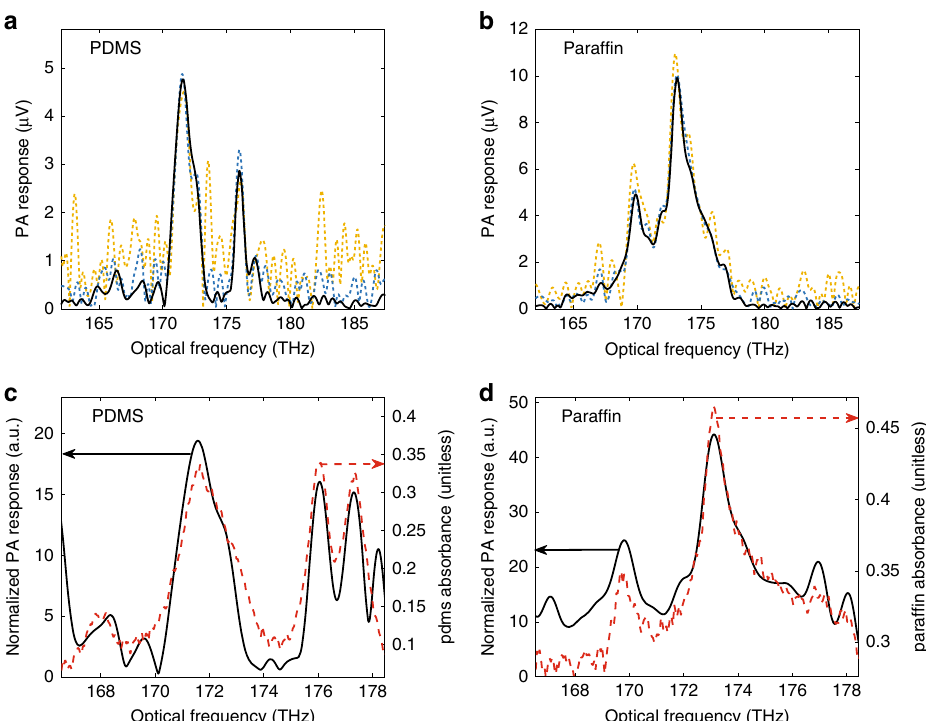
Fig. 4 Spectrally resolved dual-comb photoacoustic responses of polymer fi lms. a , b show the PA response for PDMS ( a ) and paraf fi n ( b ) obtained by Fourier transformation of the time-domain signal at the transducer output (obtained by dividing the measured signal by the ampli fi er gain) followed by scaling to optical frequencies (Eq. (2)). The averaging times are 4 min, 20 min, and 120 min for the yellow-dotted, blue-dotted, and black-solid traces, respectively. c , d show the normalized PA response from Eq. (4) (solid black) compared to the optical absorbance (base-e absorbance units) measured with a spectrophotometer (dashed red) for PDMS ( c ) and paraf fi n ( d ). See “ Methods ” section and Supplementary Note 3 for details about sample preparation. The optical excitation power is ≈ 24 mW for both the PDMS and paraf fi n